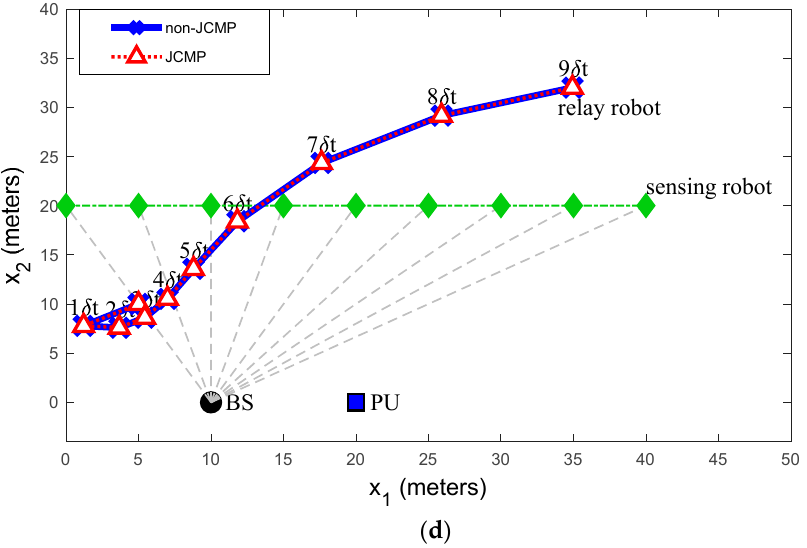
Figure 5. Optimal trajectories of the relay robot for non-JCMP and JCMP with different PU deploy- ments.